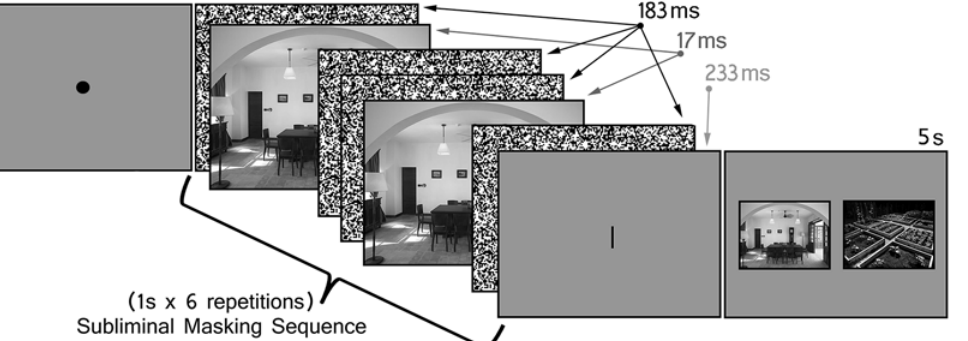
Fig 3. Objective Test of Scene Awareness. Individual trials began with the subliminal presentation of a studied scene. Participants were told that scenes were embedded in the masking sequences and were asked to select that scene from two alternatives presented for 5 seconds at the end of the trial.